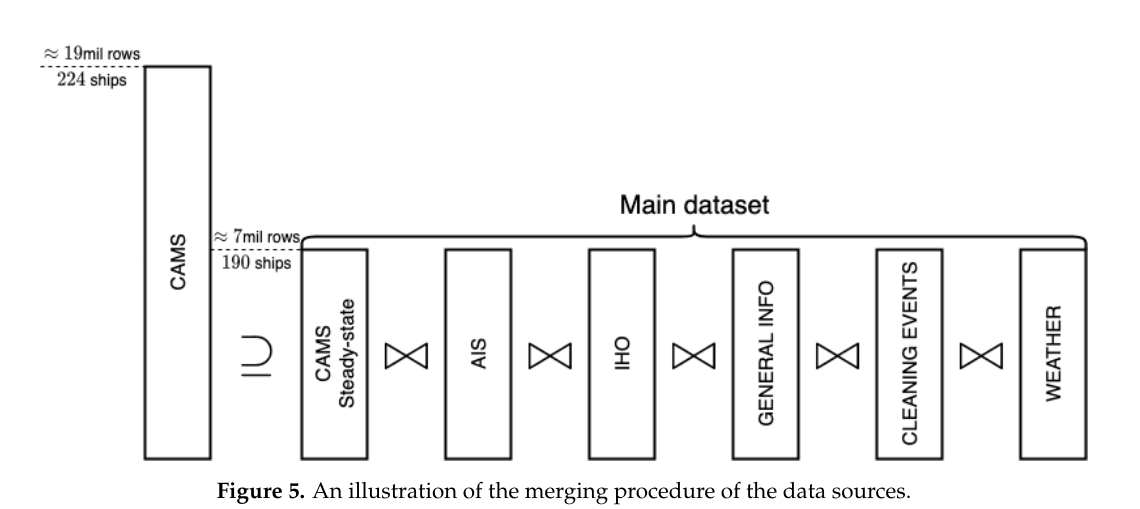
Figure 5. An illustration of the merging procedure of the data sources.